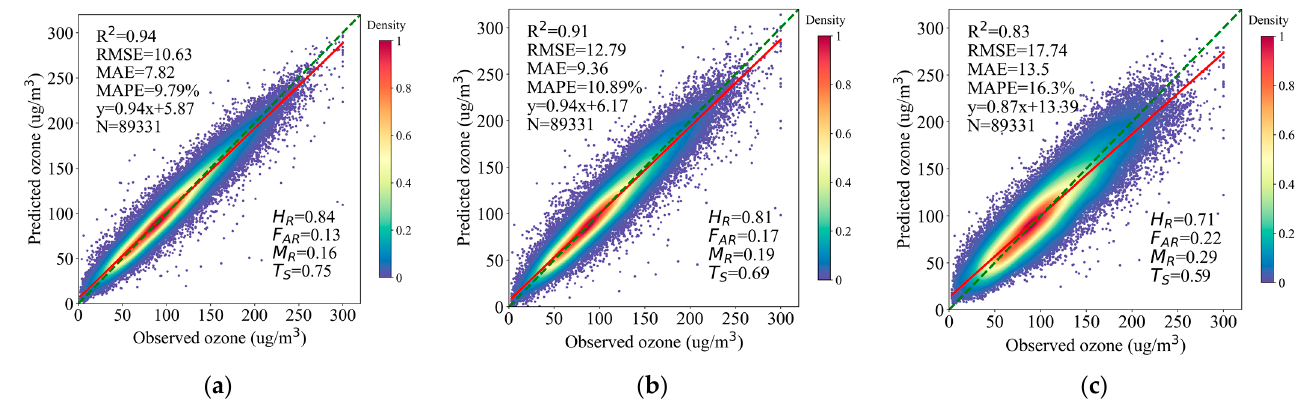
Figure 4. Density scatter plot of model predictions and in situ observations: ( a ) sample-based CV; ( b ) space-based CV; and ( c ) time-based CV.